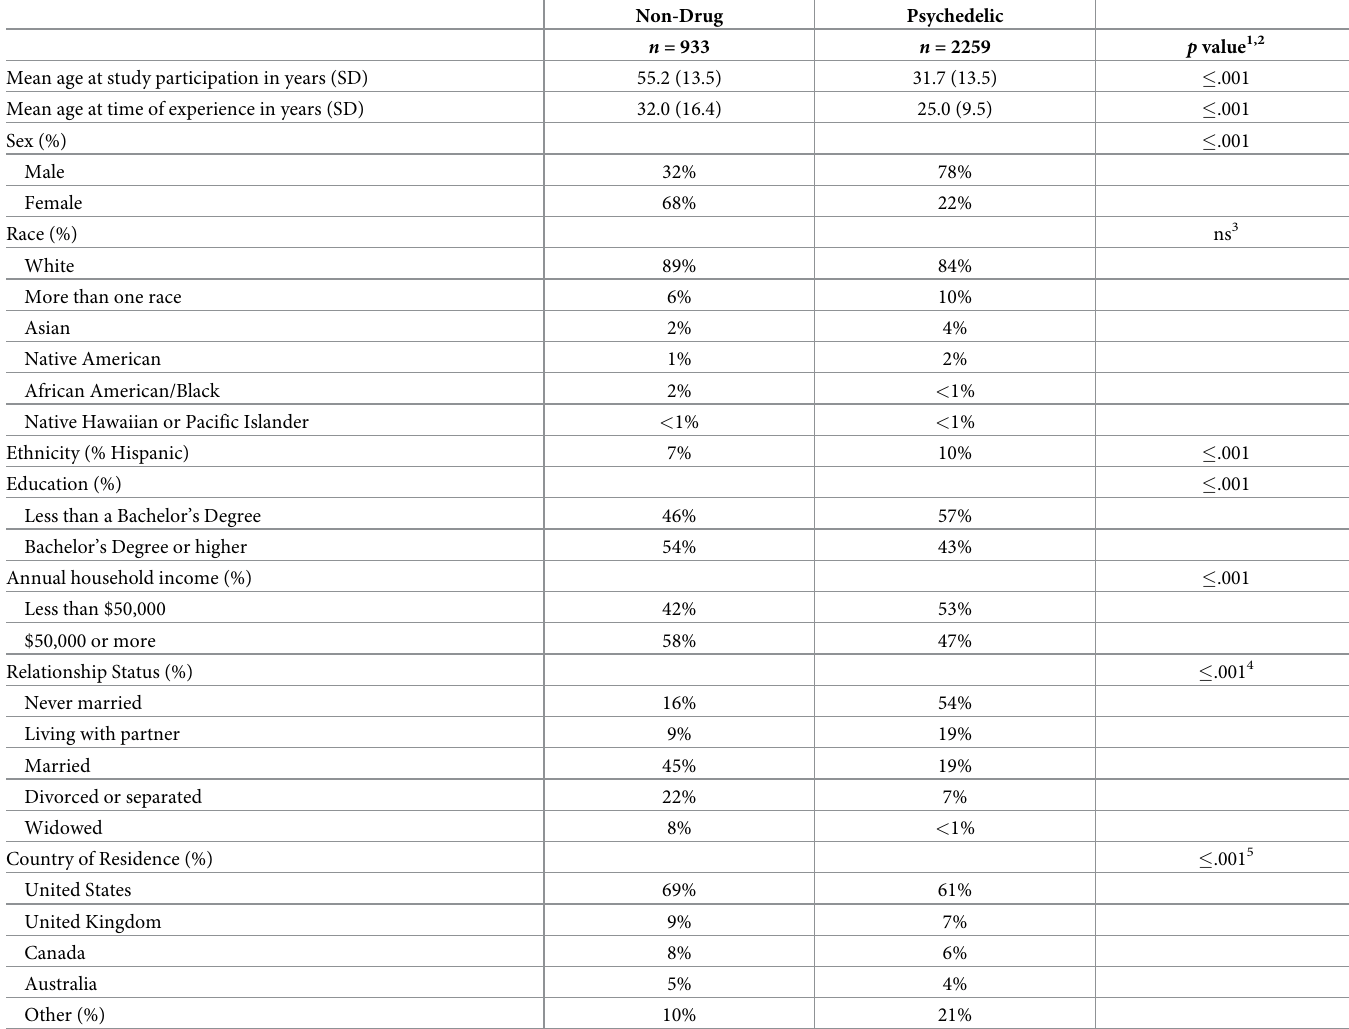
Table 1. Participant characteristics in the Non-Drug Group and combined Psychedelic